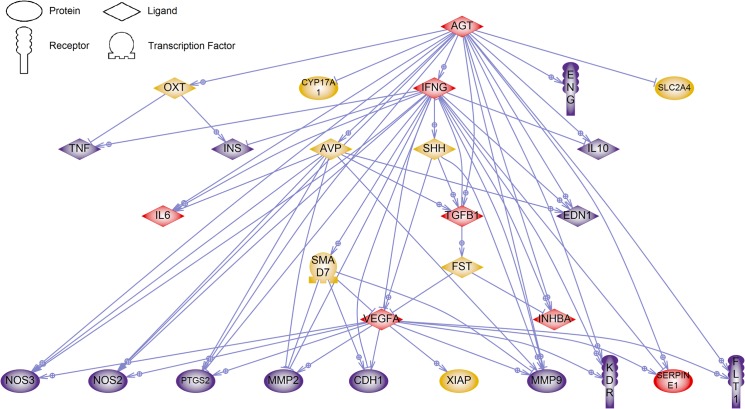
Downstream genes of identified regulators and targets of maternal PE susceptibility genes.A gene network of downstream targets of identified regulators/targets of maternal PE susceptibility genes was generated with Pathway Studio 9.0. Each link is supported by at least one published reference. Connecting genes are coloured in yellow, regulator/target genes of maternal PE susceptibility genes in red and major downstream targets of these genes in purple.